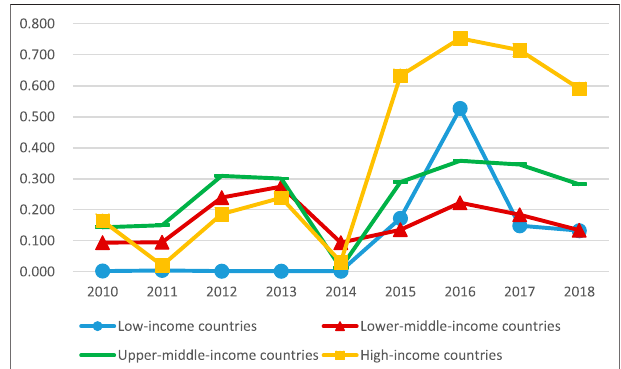
FIGURE 4 | Green investment ef fi ciency by category in B&R countries.